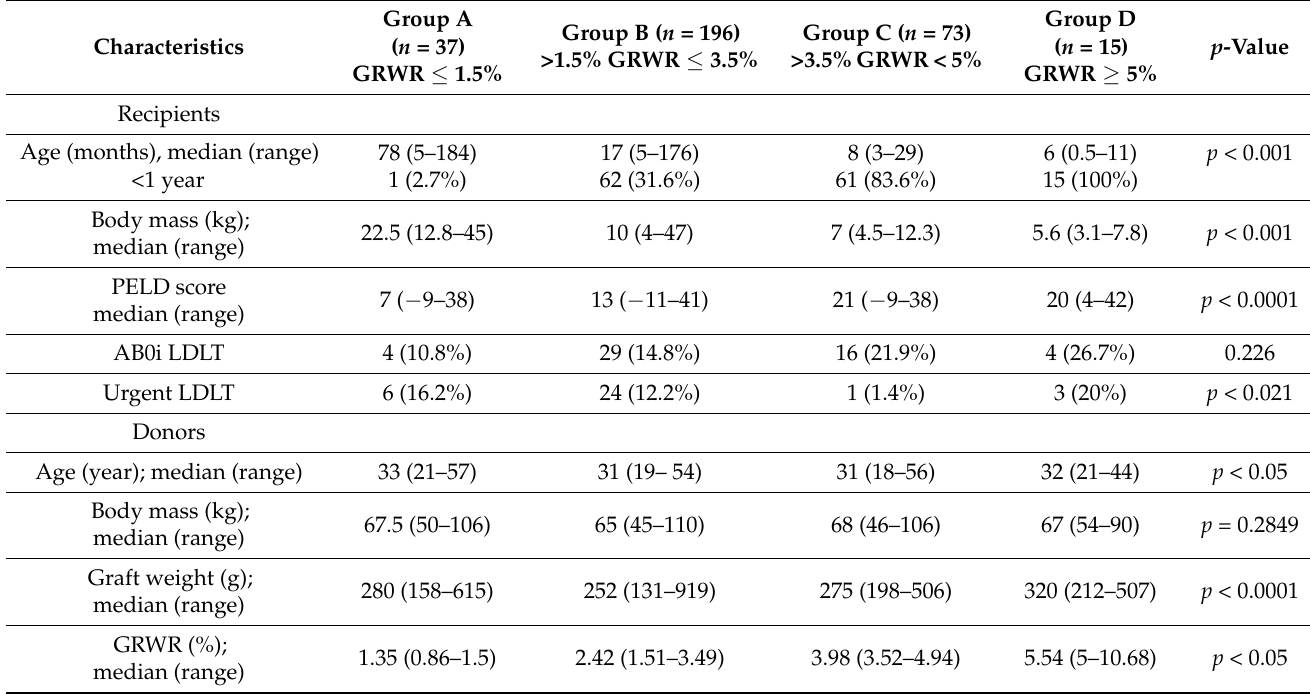
Table 3. Characteristics of donors and recipients according to GRWR.